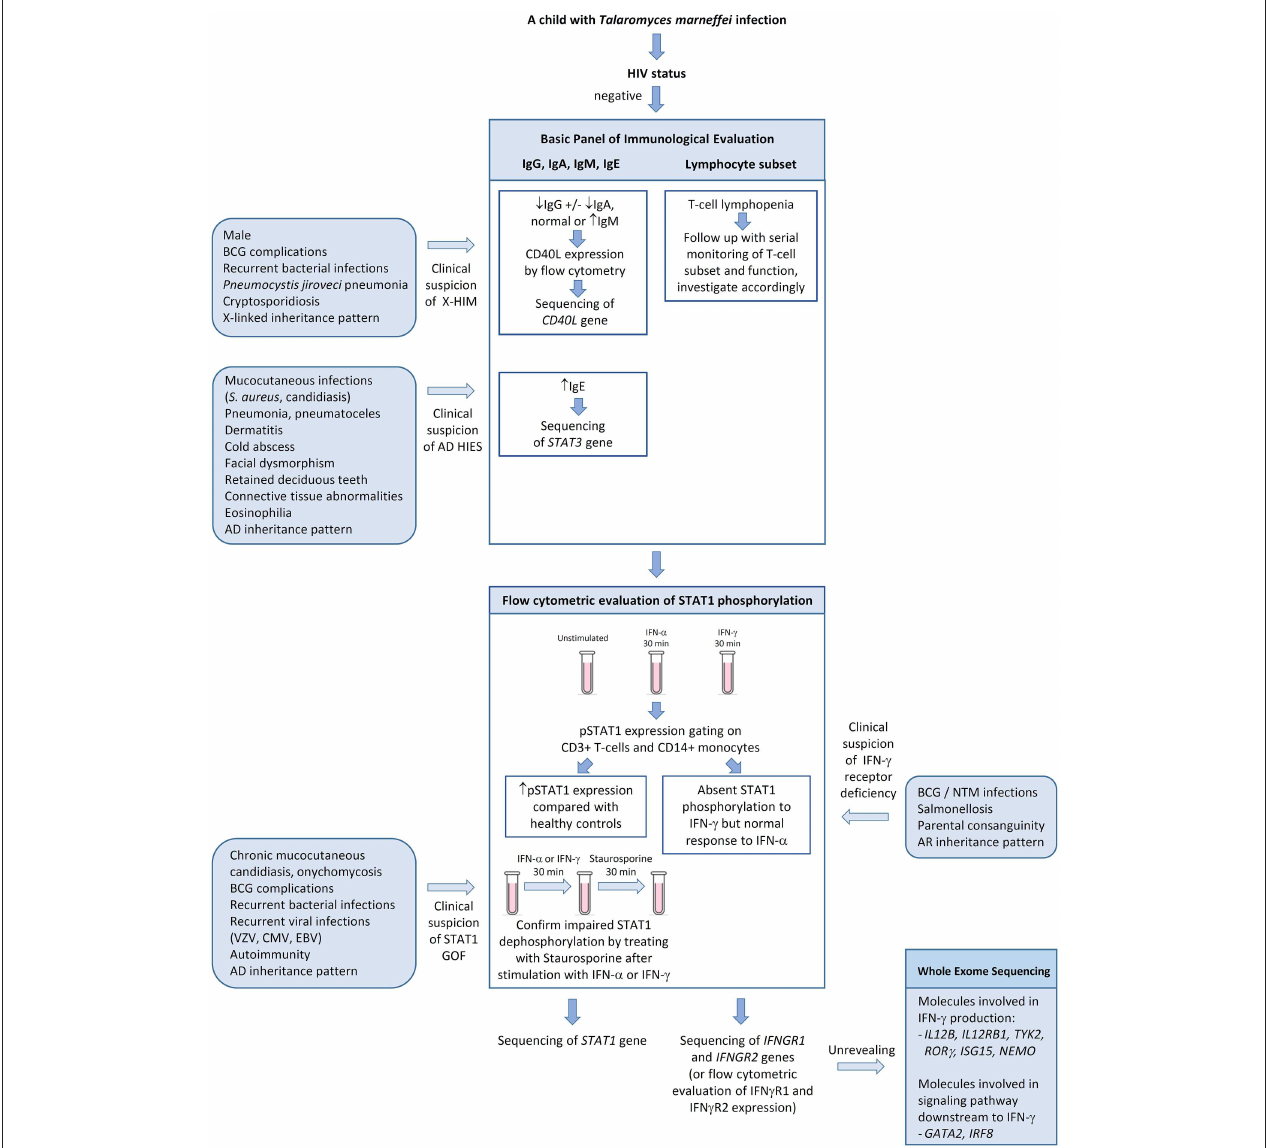
FIGURE 5 | Algorithm for immunological evaluation of pediatric patientswith disseminated Talaromyces marneffei infection. AD, autosomal dominant; BCG, Bacille Calmette-Guerin; CMV, cytomegalovirus; EBV, Epstein-Barr virus; GOF, gain-of-function; HIES, hyper-IgE syndrome; NTM, non-tuberculous mycobacteria; pSTAT1, phosphorylated STAT1; VZV, varicella zoster virus; X-HIM, X-linked hyper-IgM